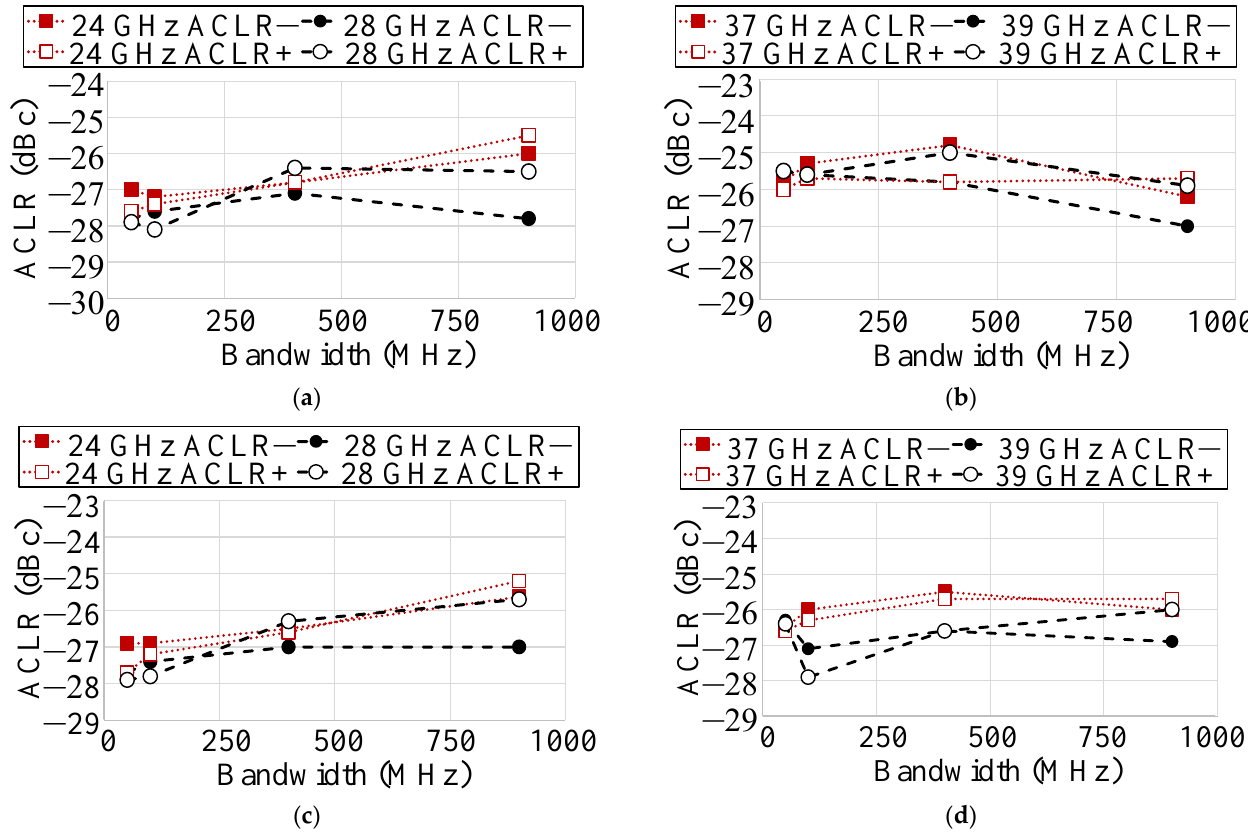
Figure 8. Measured ACLR+/ACLR- vs. 5G NR instantaneous signal BW (PAPR = 8 dB) for the broadband single-ended GaN PA with V DD = 4 V at ( a ) 24 GHz and 28 GHz, and at ( b ) 37 GHz and 39 GHz; and with V DD = 6 V at ( c ) 24 GHz and 28 GHz, and at ( d ) 37 GHz and 39 GHz.